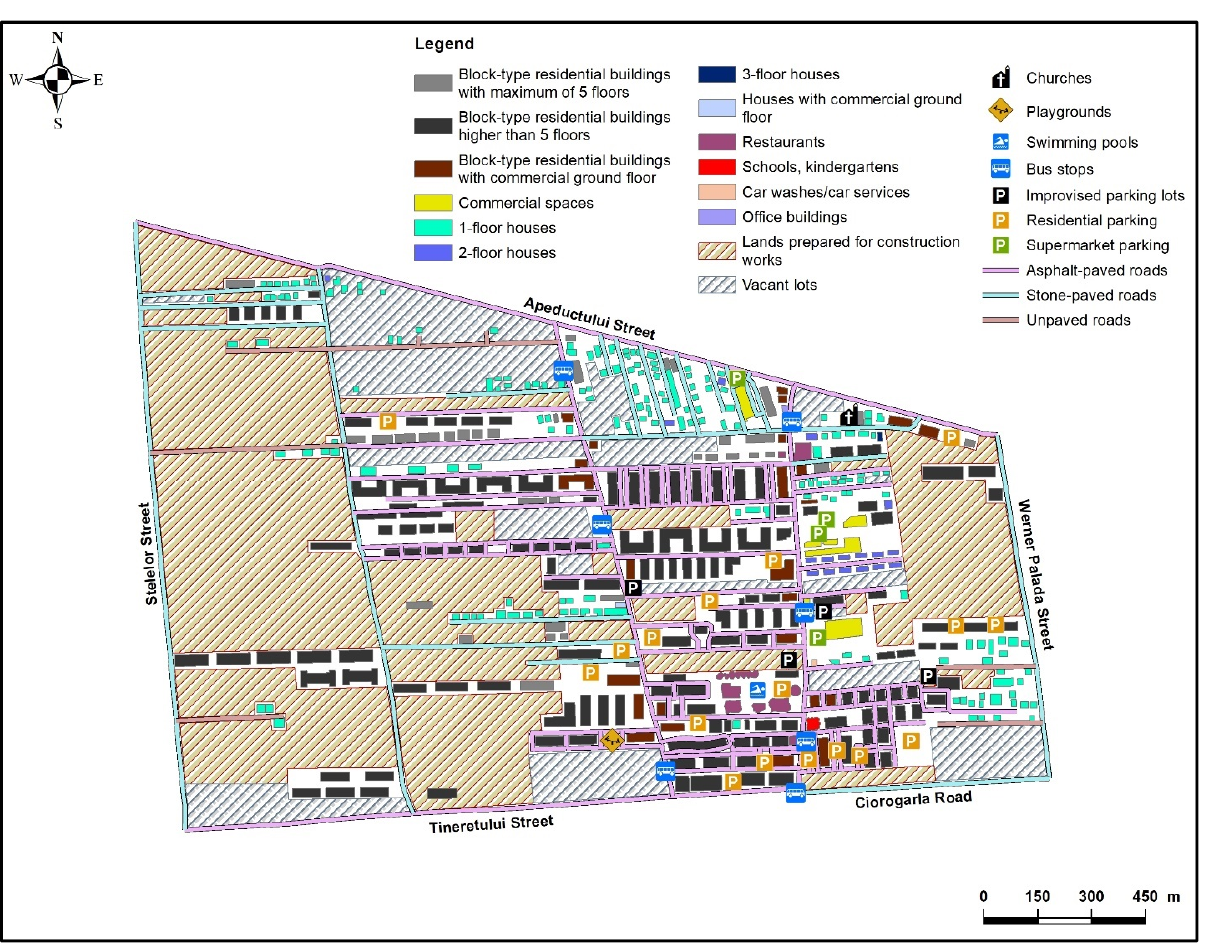
Figure 5. Residential features of the Militari–Chiajna area.